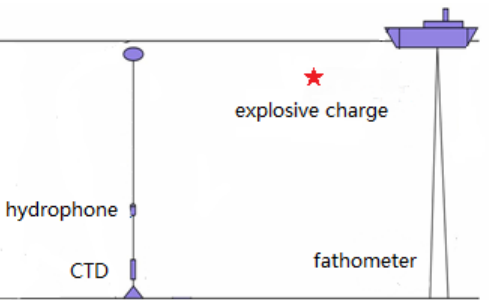
Figure 8. Diagram of experimental setup for data collection. The sound source is represented as a star mark.